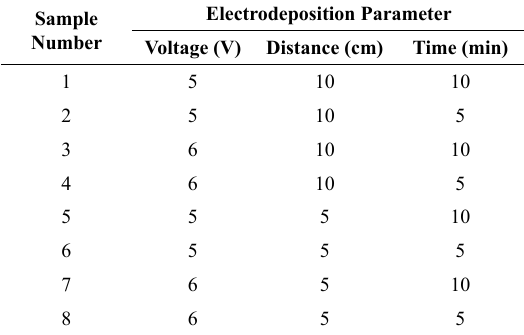
Table 1. Samples obtained with the variation of the